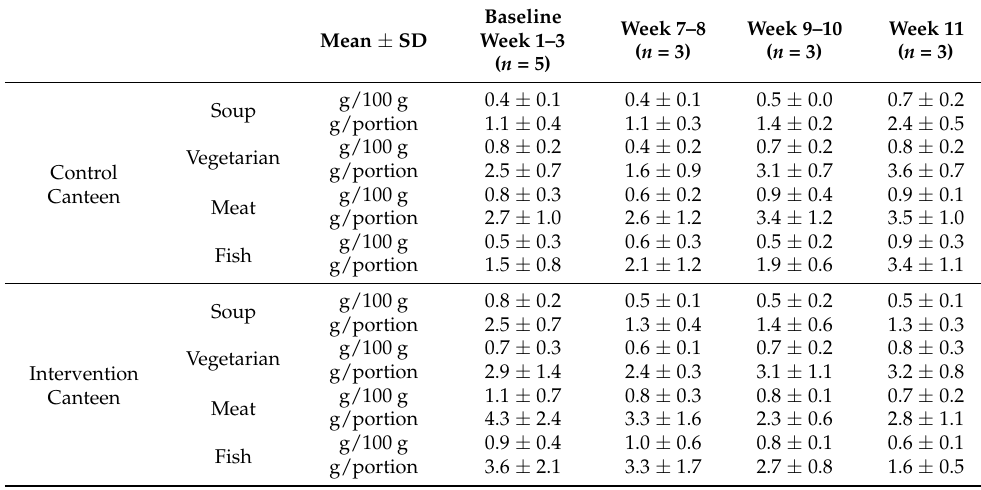
Table A1. Total salt content of the soup and main dishes per canteen over the course of the study (total sodium by chemical